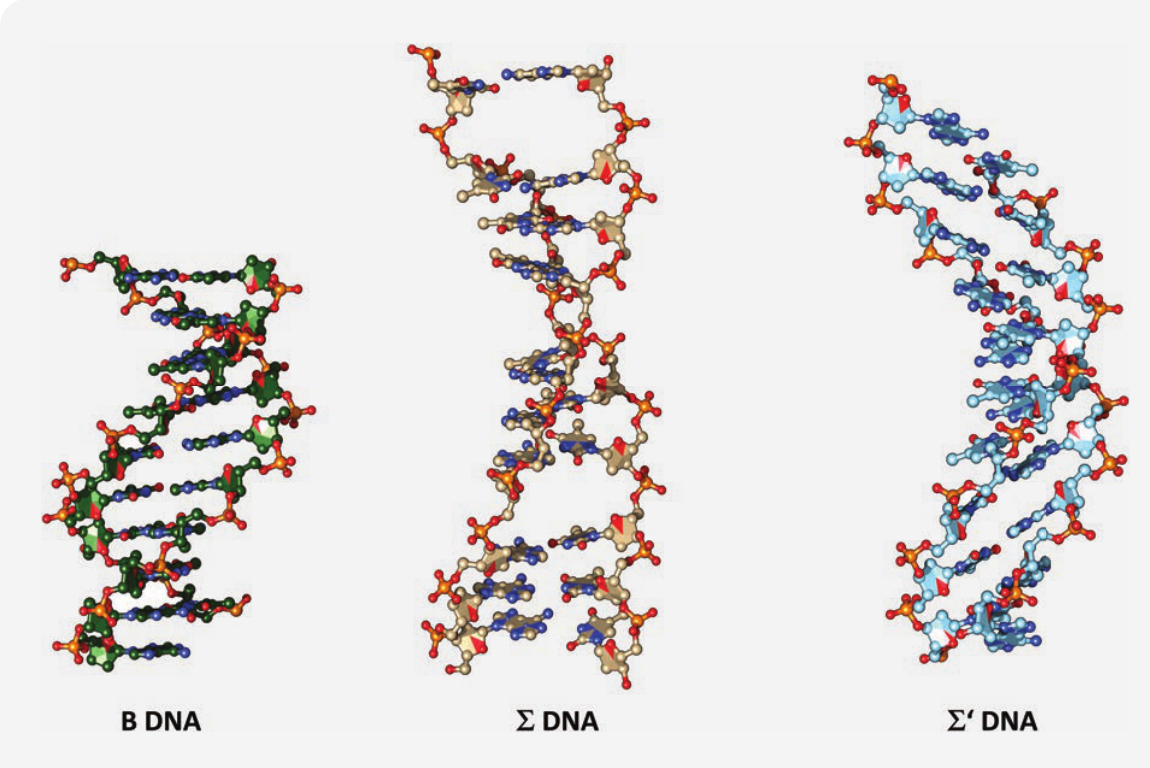
Figure 6. Two energetically plausible models for 50% elongated double-stranded DNA. Right: a homogeneously stretched model with tilted bases ( Σ′ ). Middle: an inhomogeneous model with perpendicular bases ( Σ ). Left: normal B DNA. From the perpendicular base orientation evidenced from Figs. 4, 5, the Σ′ structure was excluded in favor of Σ . Structures kindly provided by Dr Anna Reymer 26